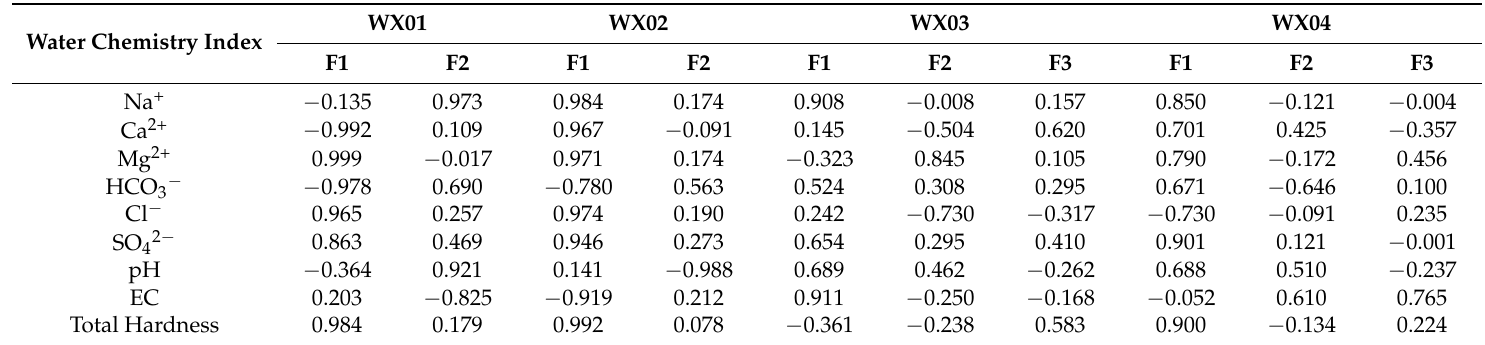
Table 5. Rotational factor load matrix for the groundwater at different